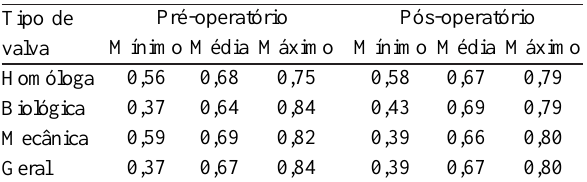
Tabela 3. Medidas descritivas da fração de ejeção pré e pós- operatória pelo método Cubo, por tipo de